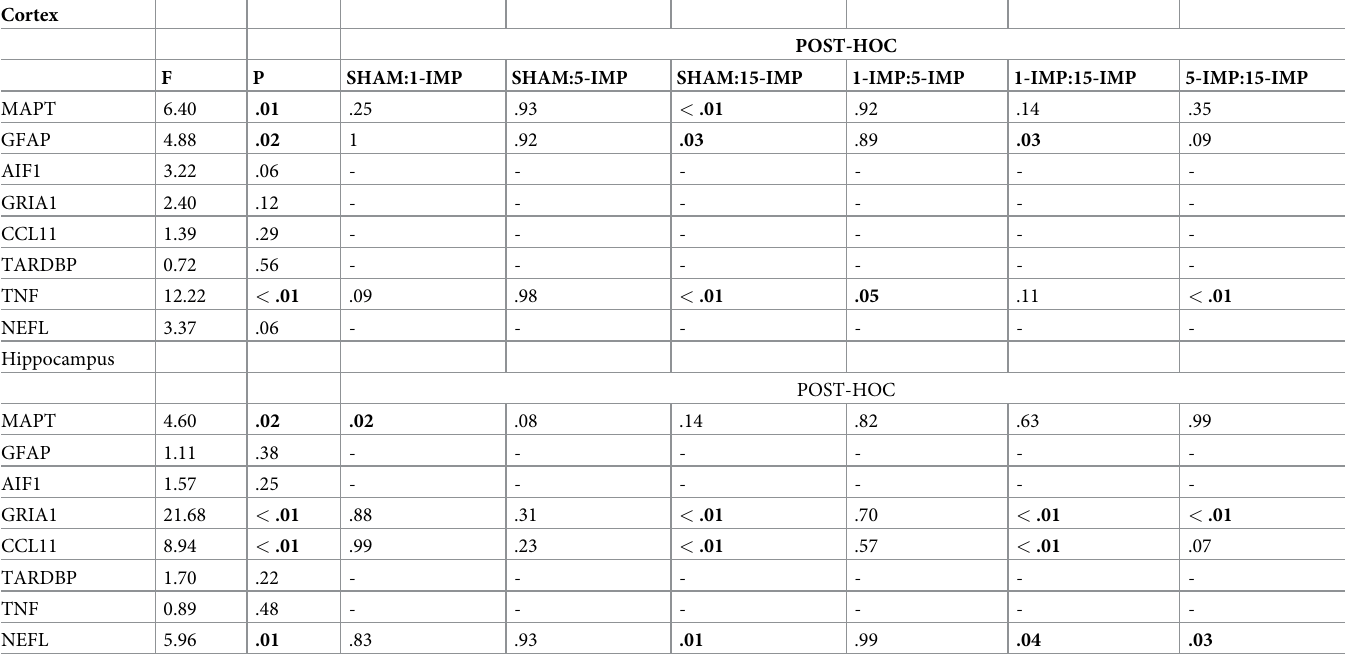
Table 1. Statistical results obtained from the one-way ANOVAs for changes in expression of the eight genes of interest for the two brain regions at acute sacrifice (48-hour post-mTBI). Cortex